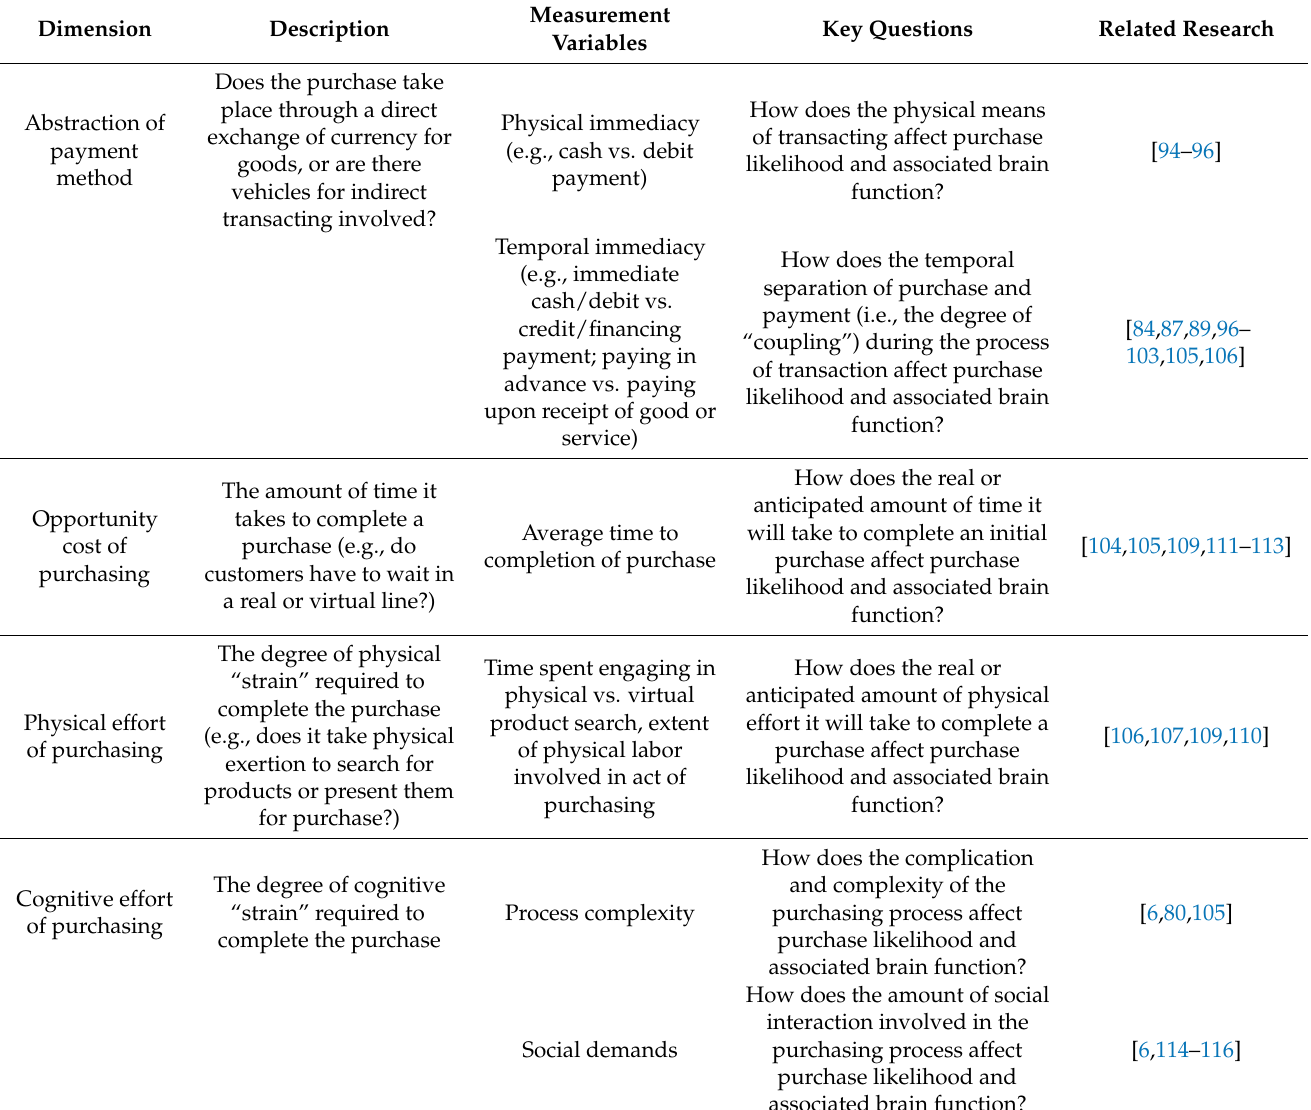
Table 1. Anticipated Costs (“Pain of